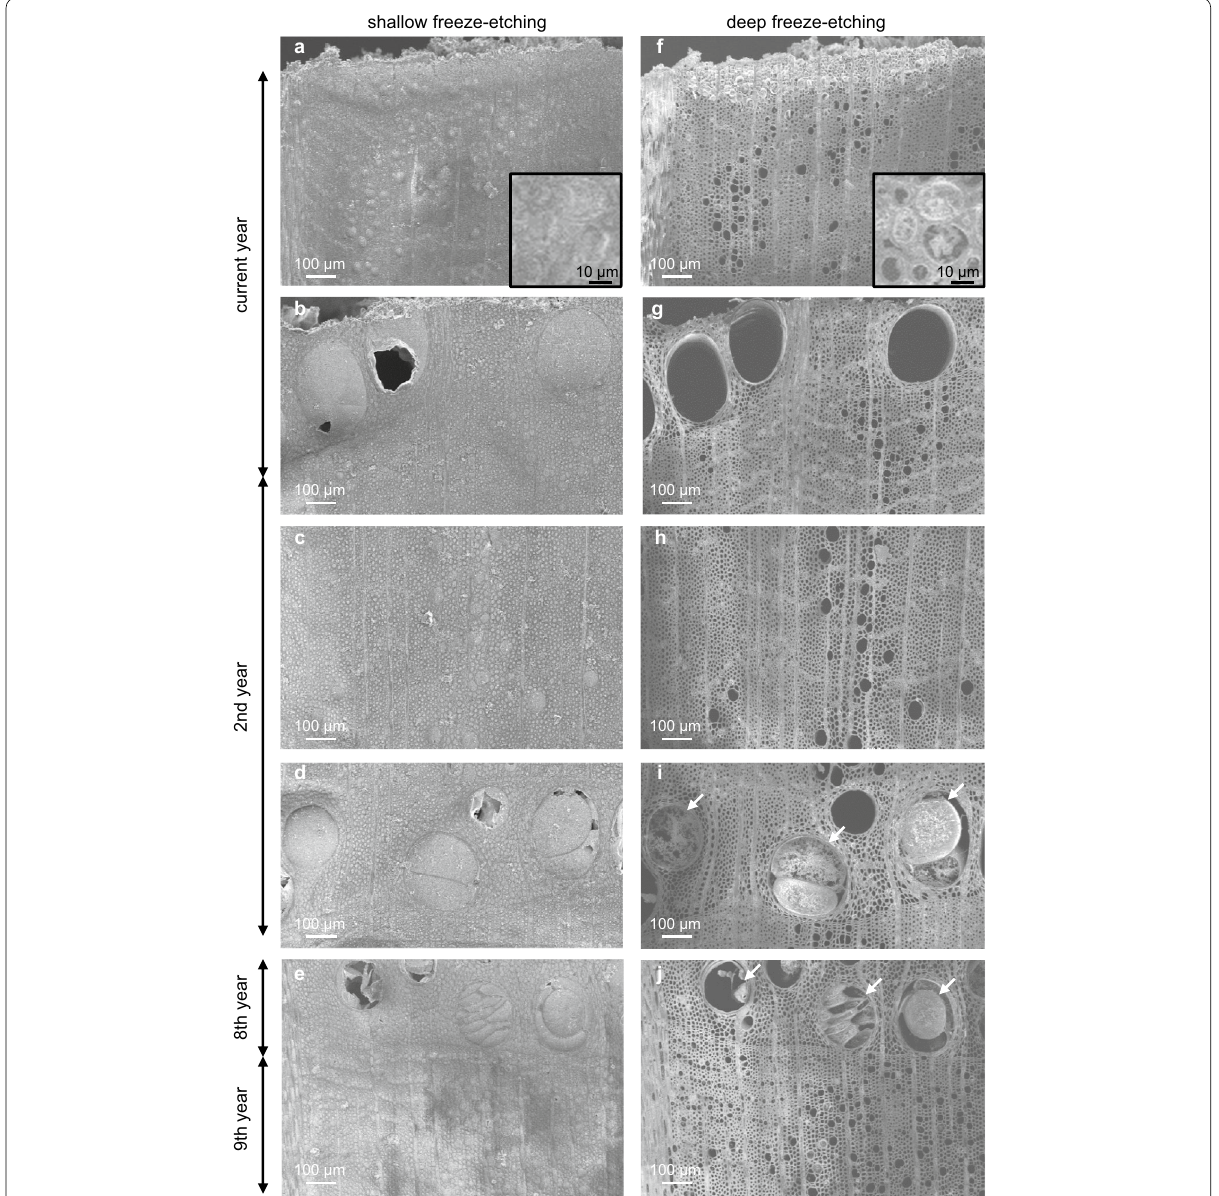
Fig. 6 Typical water distribution and cellular structures in konara oak ( Quercus serrata ) observed by cryo-scanning electron microscopy (cryo-SEM). A transverse section of annual rings from the current year, the 2nd year, and 8–9th year (innermost part of the sapwood) of a control (without Cs injection) of a normal tree (K06). Water distribution is clearly distinguished from cell walls, cell content, and tyloses (white arrows) as seen from the comparison between shallow ( a – e ) and deep freeze-etching ( f – j ) because deep freeze-etching removed sublimated ice. The boxes in a and f represent magnified images of axial parenchyma